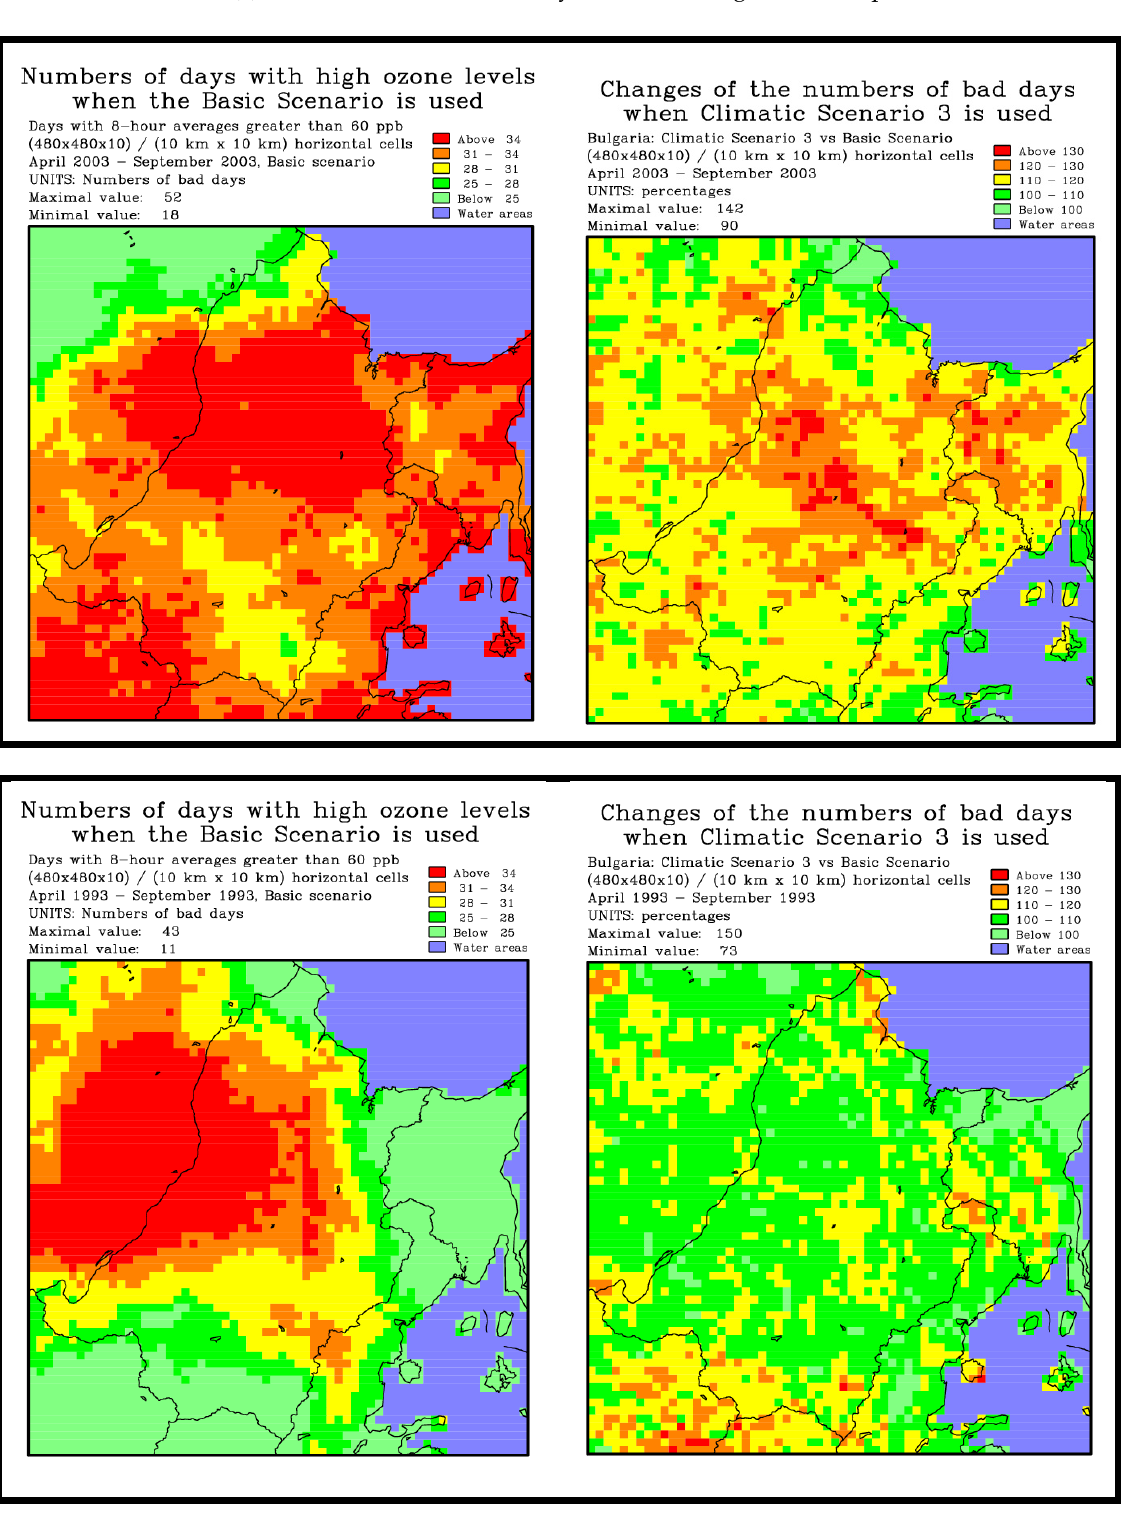
Figure 7. Results obtained in the sub-domain of UNI-DEM containing Bulgaria. Numbers of “bad days” in year 2003 (the upper left-hand-side plot) and in year 1993 (the lower left-hand-side plot). The increases when the third climatic scenario is used are given in the two right-hand-side plots.